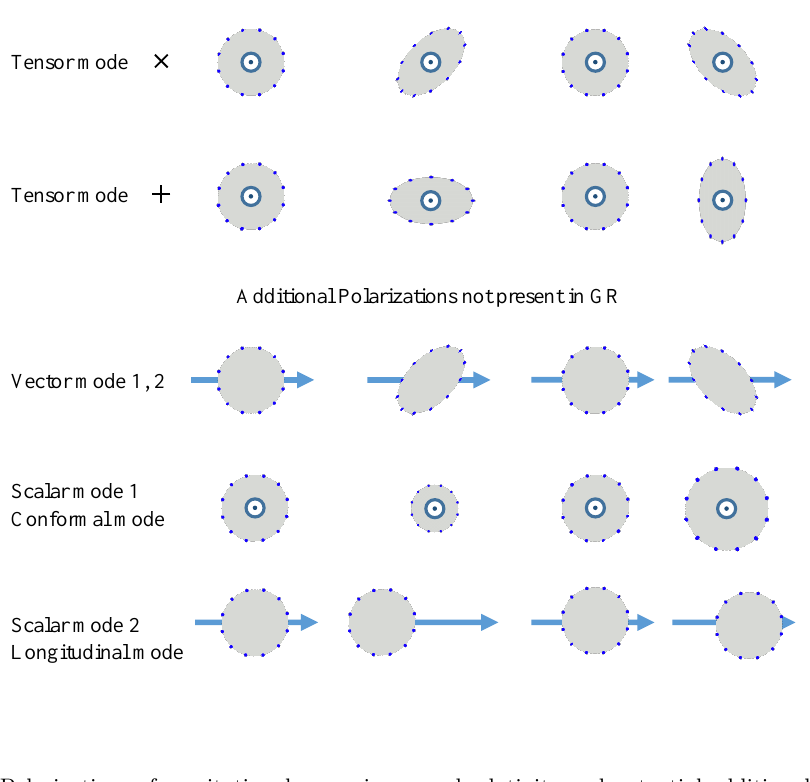
Figure 6: Polarizations of gravitational waves in general relativity and potential additional polarizations in modified